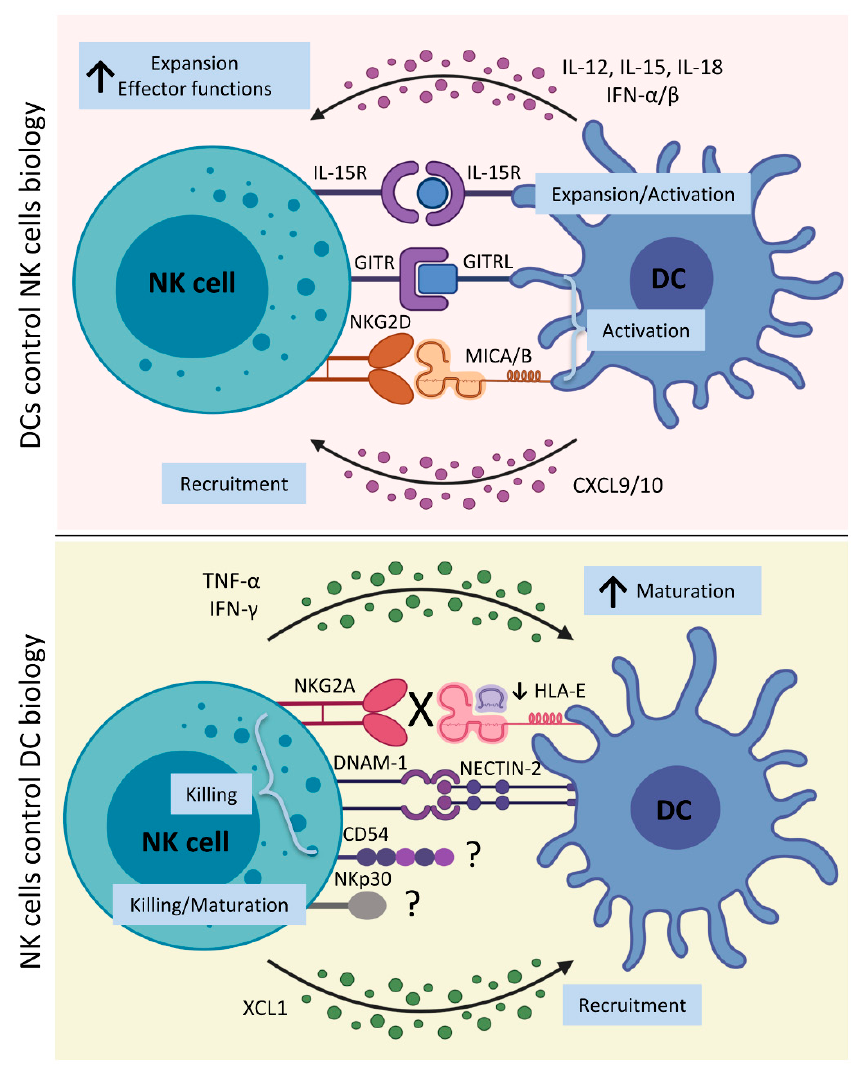
Figure 1. DC–NK cell interplay. Upper panel : After exposure to several stimuli recognized by a wide variety of pattern recognition receptors expressed by DCs, they release different